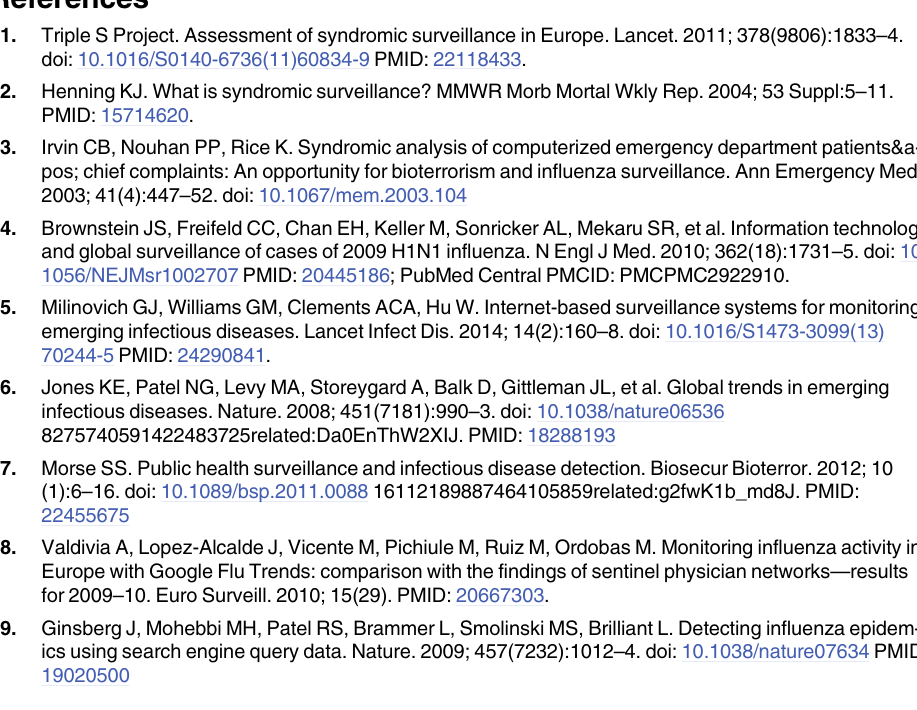
S4 Fig. Time series plots of number of search queries having a strong correlation (r-value of (cid:1) 0.7) with KCDC virologic data from lag correlation analysis (two weeks preceding of search query).